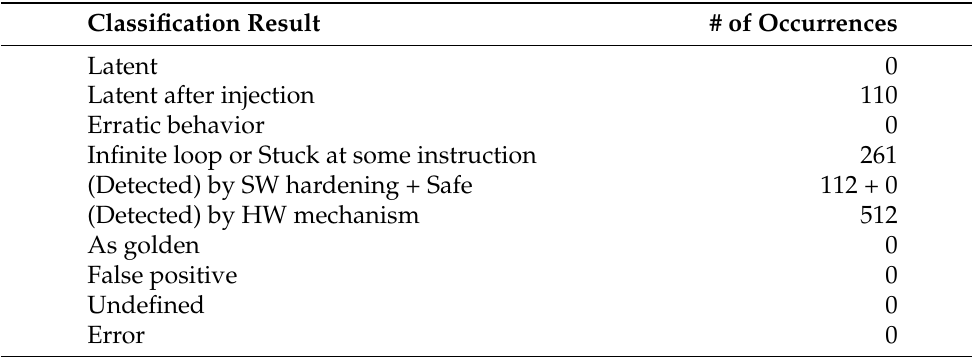
Table 3. Classifier results obtained from the fault injection campaign assessing the YACCA algorithm implemented on the timeline scheduler.